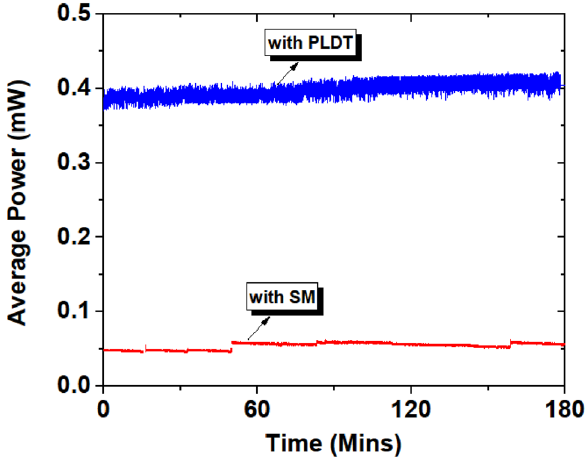
Figure 13. Measured average output power as a function of time for SA prepared using SM and PLDT.